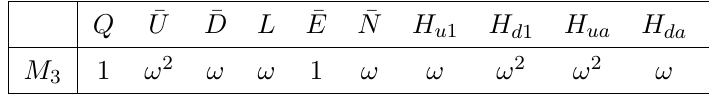
Table 2 . The representation of charged particle under matter triality within the extra-Higgs (cid:12)elds. the extra generation is denoted as Roman index. Under this discrete symmetry, the baryon number violating operator is prohibited up to mass dimension-5 (more detailed discussion, see appendix